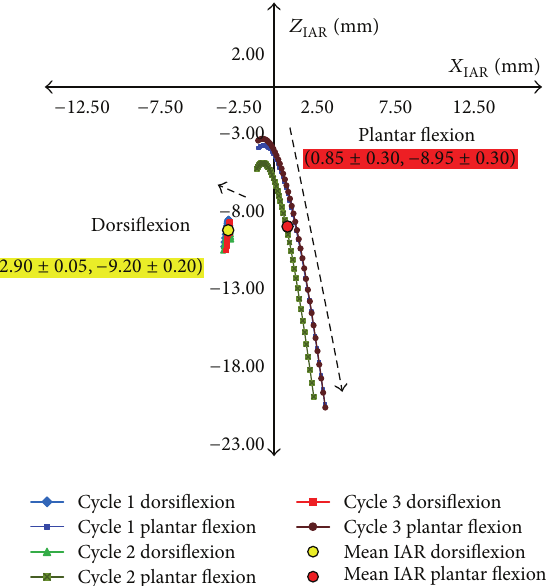
Figure 8: IAR paths of specimen 1 during dorsiflexion and plantar flexion plotted on medial radiographs. Mean IAR values for all three cycles(circles)withstandarddeviations(toosmalltosee)areshown. Dashed arrows denote the direction of the IAR through rotation.